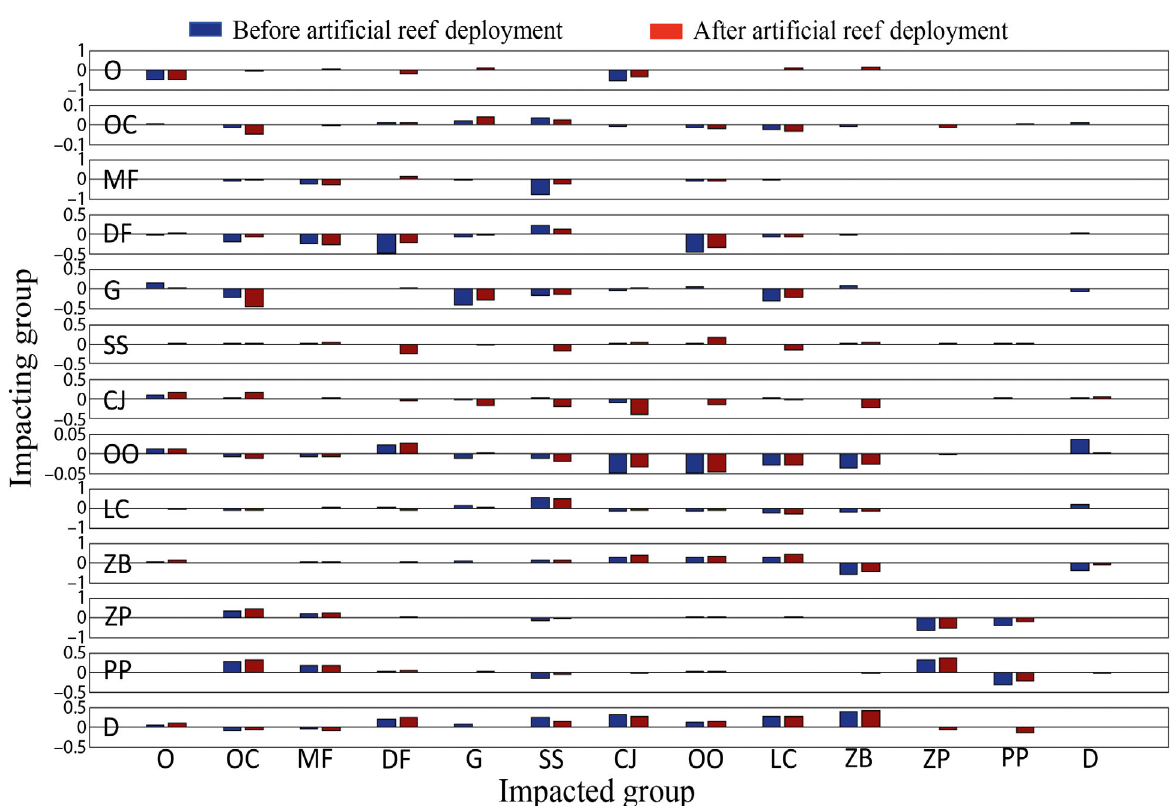
Fig. 3. Comparison of mixed trophic impact analysis results before and after artificial reef deployment. Impacting and im- pacted groups are placed along the vertical and horizontal axis, respectively. Positive impacts are shown above the baseline; negative impacts are below the baseline. The impacts are relative but comparable between groups. O: Octopodidae; OC: other cephalopods; MF: mesopelagic fishes; DF: demersal fishes; G: Gobiidae; SS: Sebastes schlegelii ; CJ: Charybdis japonica ; OO: Oratosquilla oratoria ; LC: large crustaceans; ZB: zoobenthos; ZP: zooplankton; PP: phytoplankton; D: